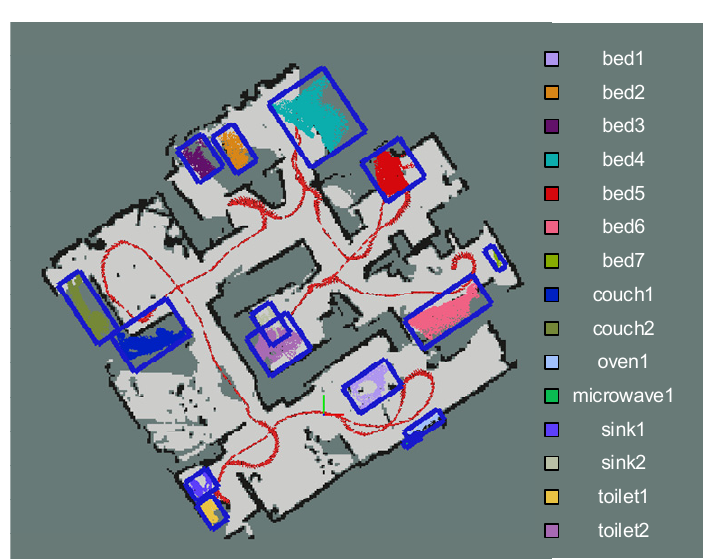
Figure 10. Object point cloud with object ‐ orientated minimum bounding rectangles.